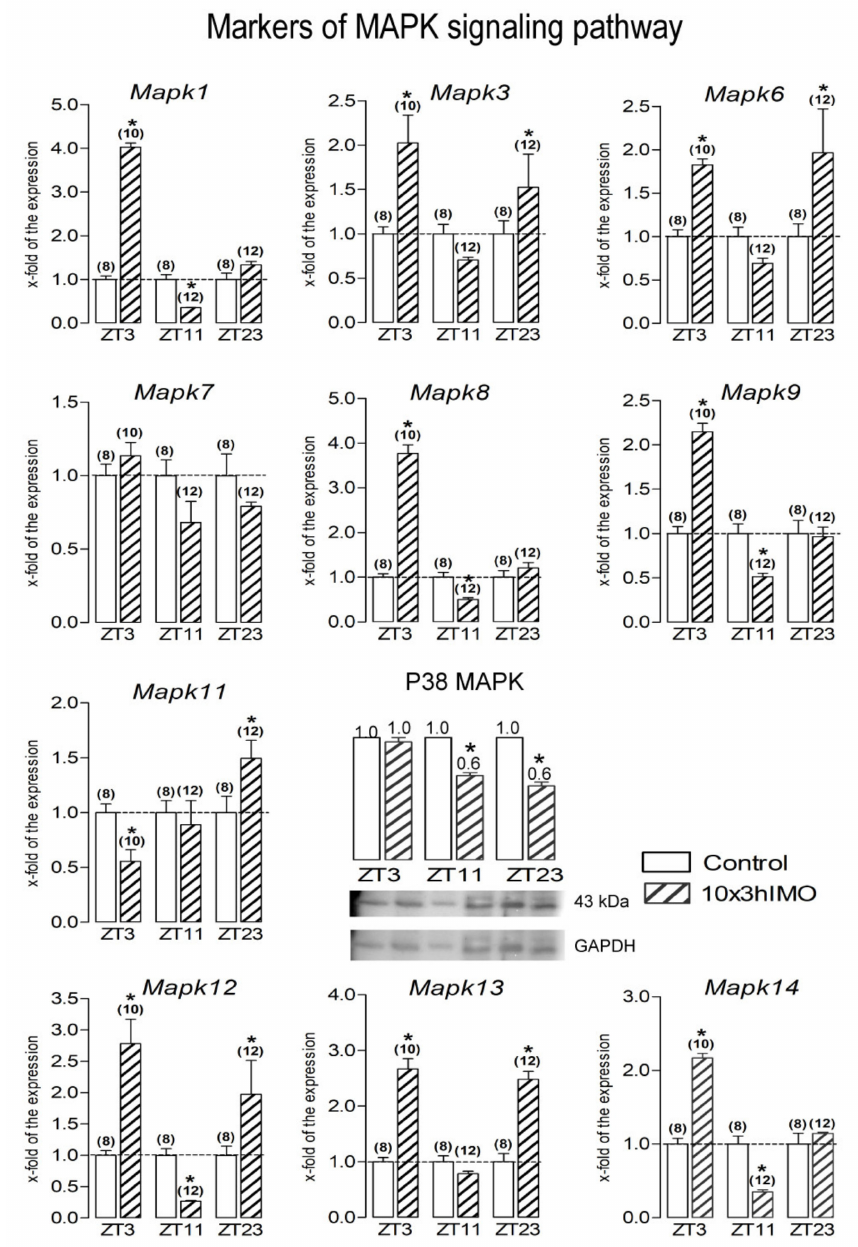
Figure 9. Different transcriptional profiles of markers of MAPK signaling regulating mitochondrial dynamics and functionality as well as spermatozoa number and functionality in spermatozoa of repeatedly stressed adult rats at different time points. Spermatozoa isolated from undisturbed and repeatedly stressed rats were used for RNA and protein isolation and further analysis of the transcriptional profile and protein expression profile of markers of MAPK signaling pathway. The representative blots are shown as panels. Data from scanning densitometry were normalized to GAPDH (endogenous control). Values are shown as bars above the photos of blots and numbers above the bars present fold of change. Data bars are mean ± SEM values of two independent in vivo experiments (n = number of rats). Statistical significance was set at level p < 0.05: * vs. control group of the same time